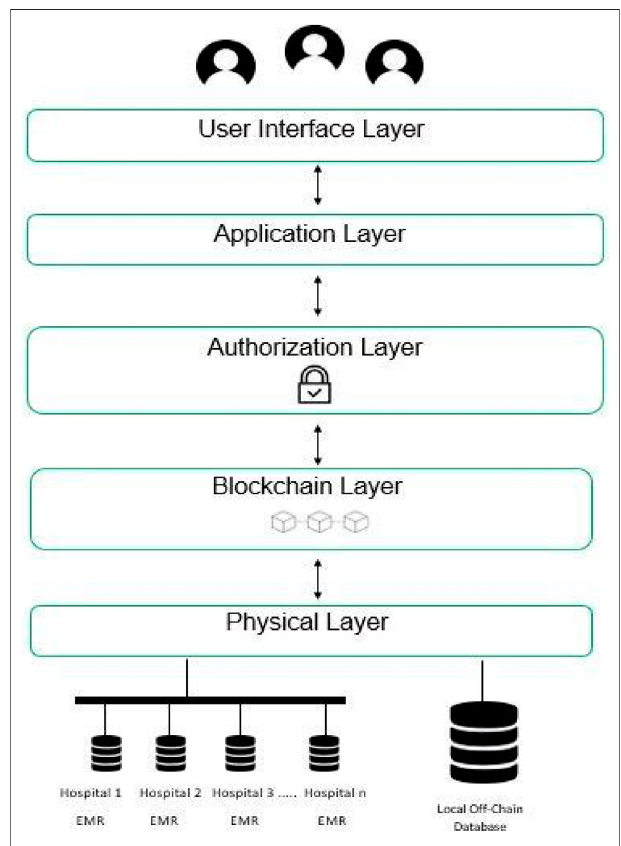
FIGURE 7 | eHomeCaregiving architecture